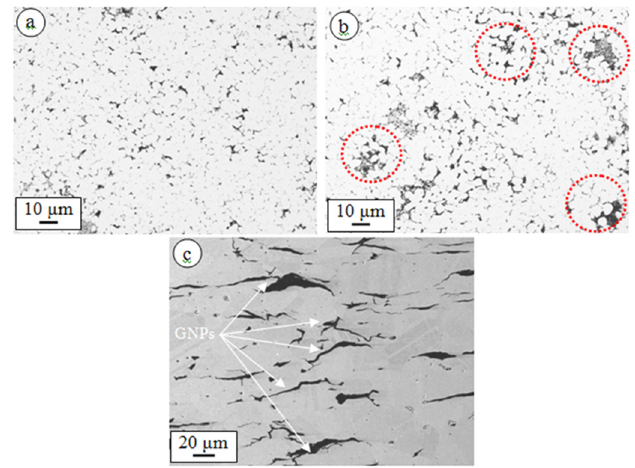
Figure 7. Scanning electron microscopy images of sintered: ( a ) Cu ‐ 4 vol % GNPs; ( b ) Cu ‐ 8 vol % GNPs parallel to the consolidation direction; and ( c ) Cu ‐ 8 vol % GNPs perpendicular to the consolidation direction [96].